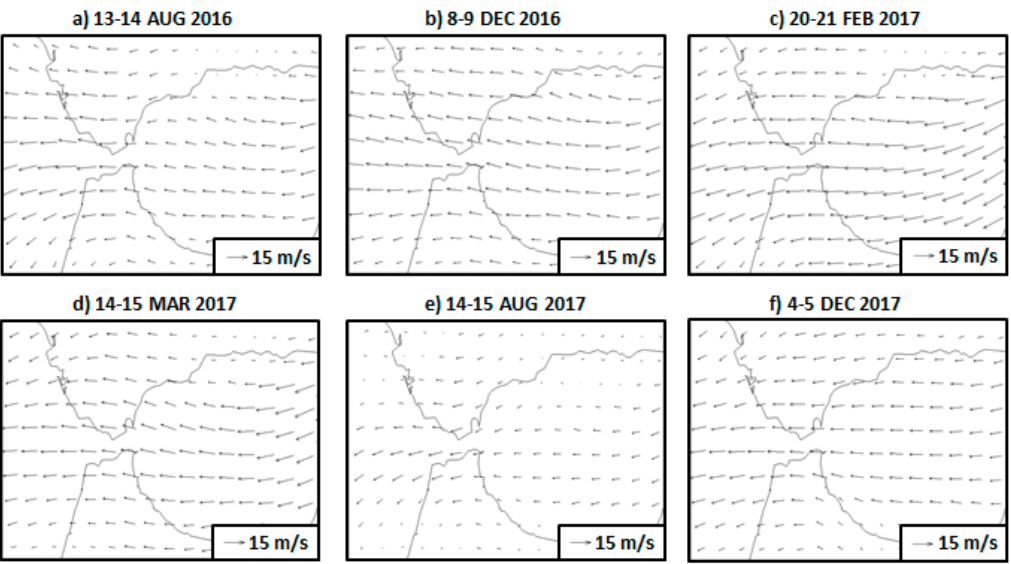
Figure 8. 2-day averaged maps of wind at 10 m height (provided by the European Center of Medium Weather Forecast (ECMWF)) related to the six Atlantic Jet (AJ) inflow reversal events analyzed during the period 2016–2017.